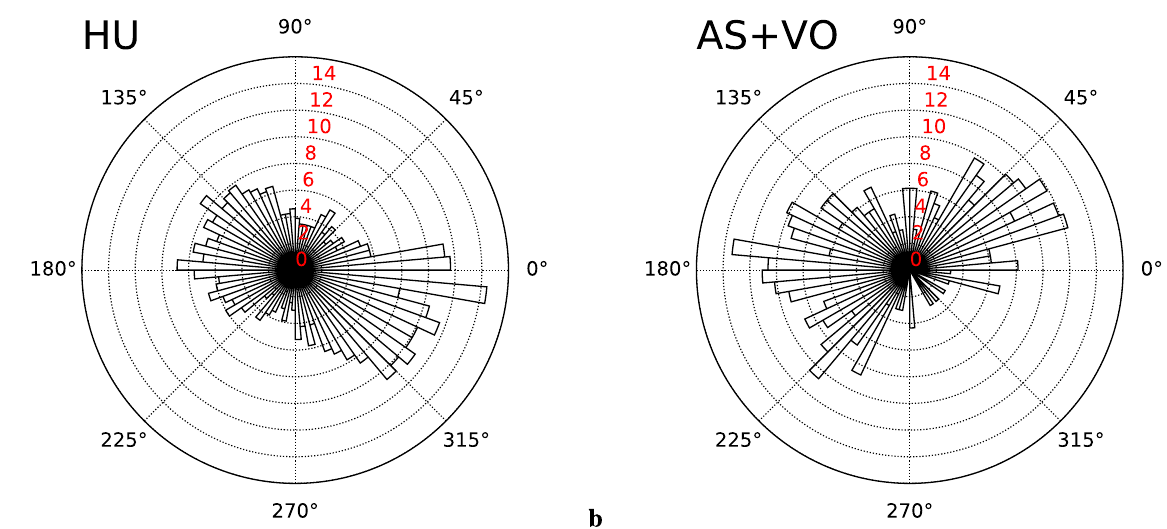
Figure 4. The circle histograms of the synchronized participant are only (PLI > 0.5) in HU and AS+VO conditions which show the proportion of obtained gait phase differences at every five deg. The height in radius direction shows the normalized range of 0–16%